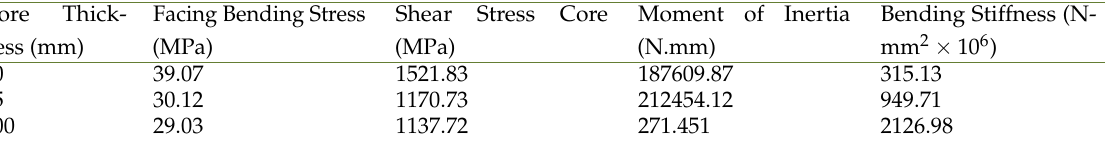
Table 2. Properties of Sandwich Panel